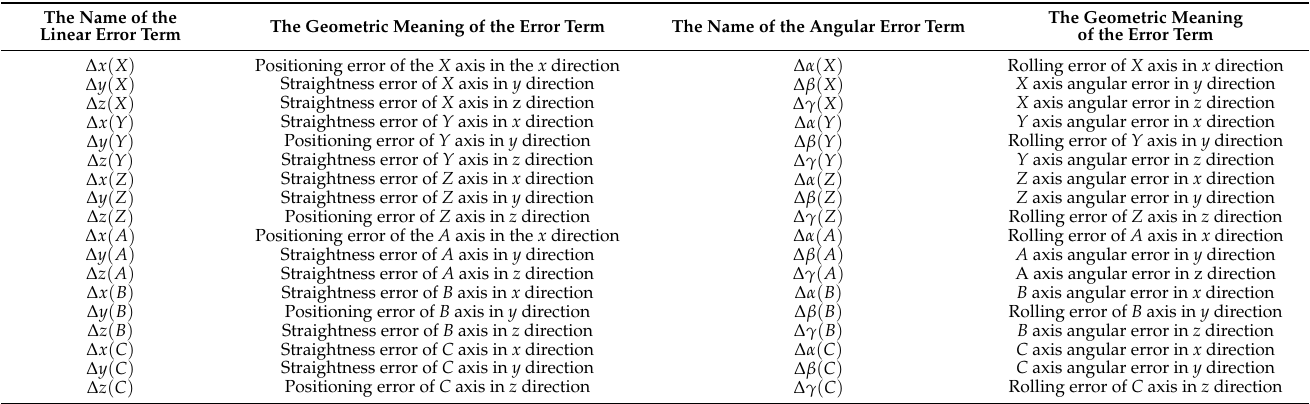
Table 1. Definition of